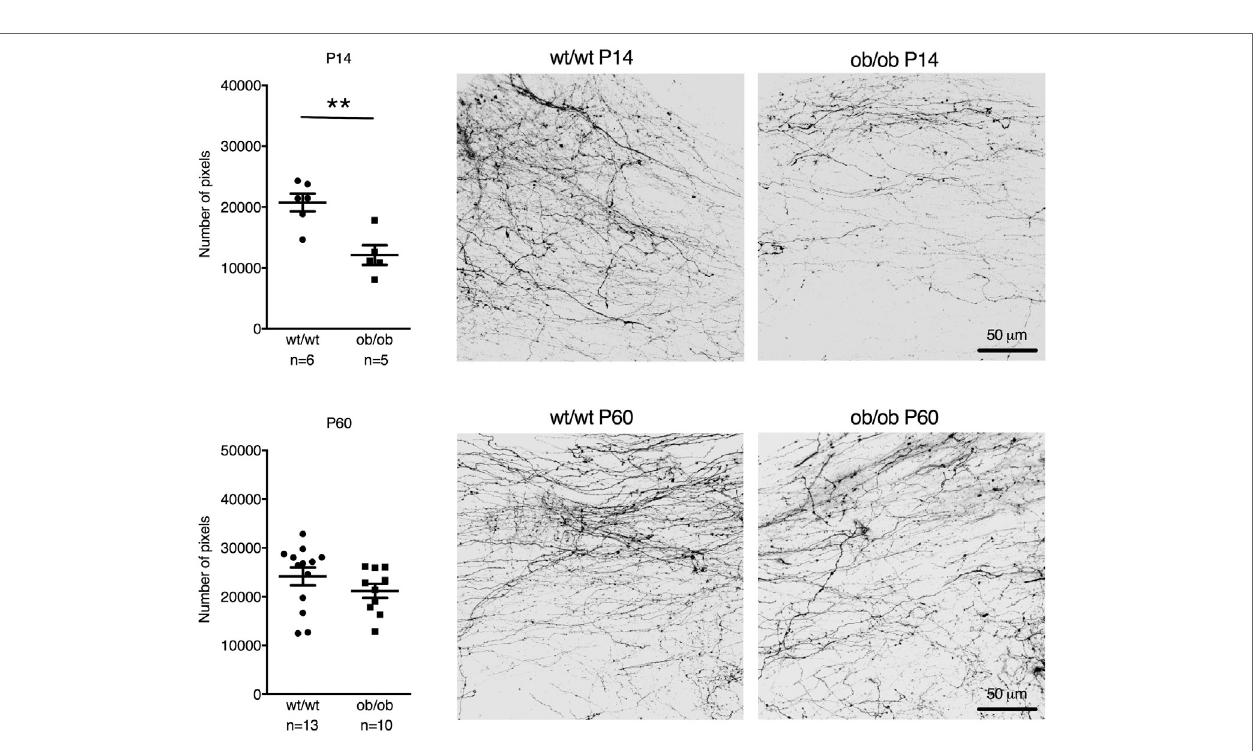
FigUre 3 | Quantification and representative images of DiI staining of area postrema–NTS projections in P14 (upper panel) and P60 (lower panel) wt/wt and leptin-deficient ob/ob mice. Leptin deficiency resulted in reduced fiber densities compared to controls in P14 but not P60 mice (** p < 0.01, Student’s t